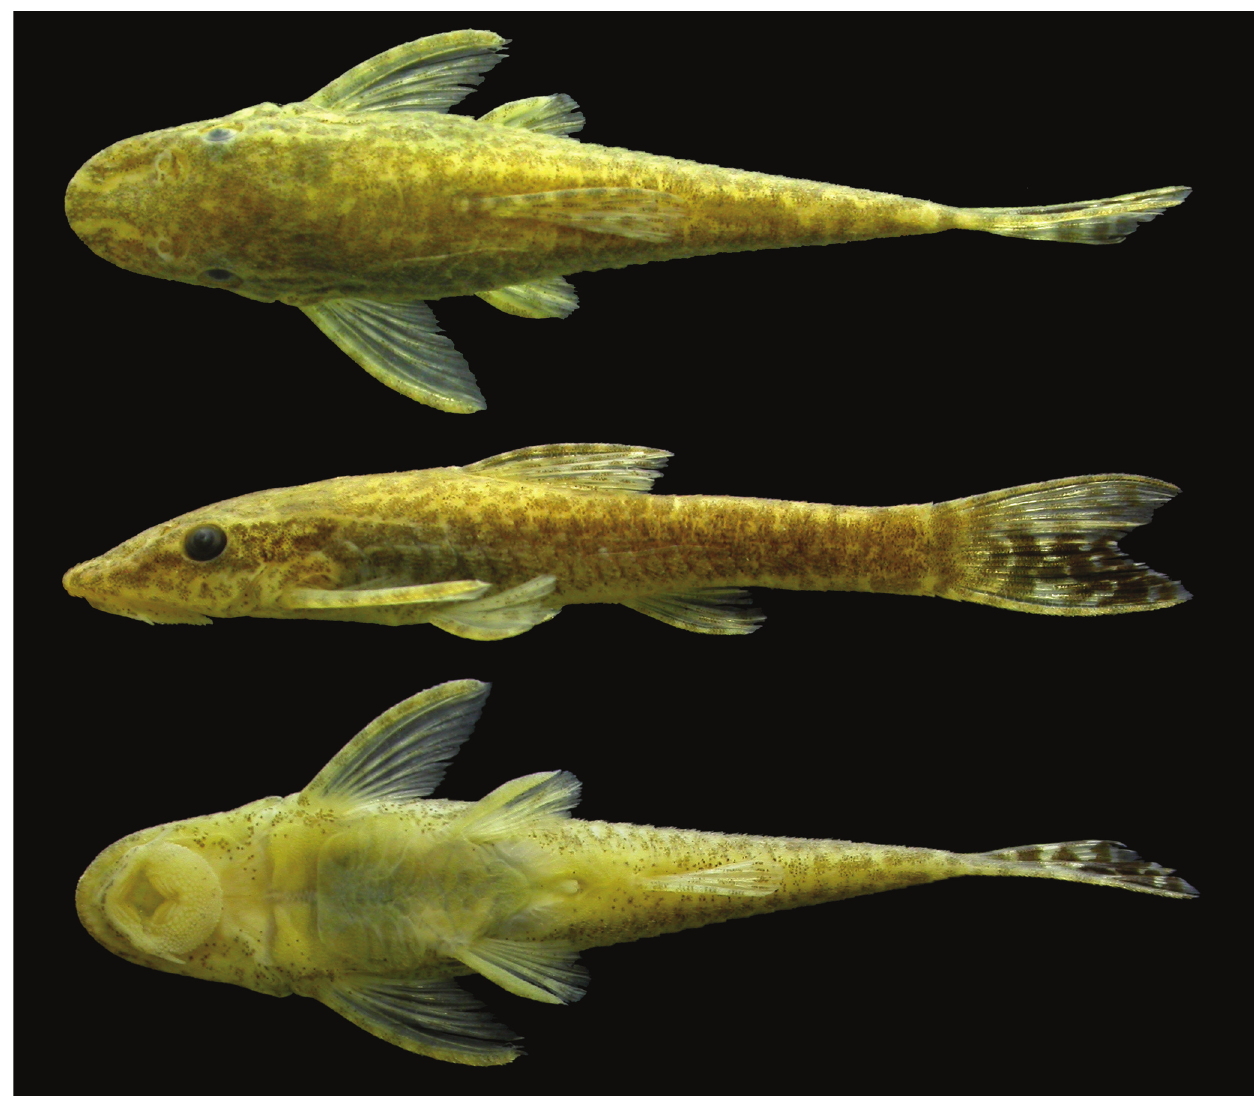
Fig. 3. Otothyropsis piribebuy , holotype, CZCEN 332, 28.8 mm SL, female, Paraguay, Departamento Cordillera, Eusebio Ayala, río Piribebuy a tributary to the río Manduvira, río Paraguay